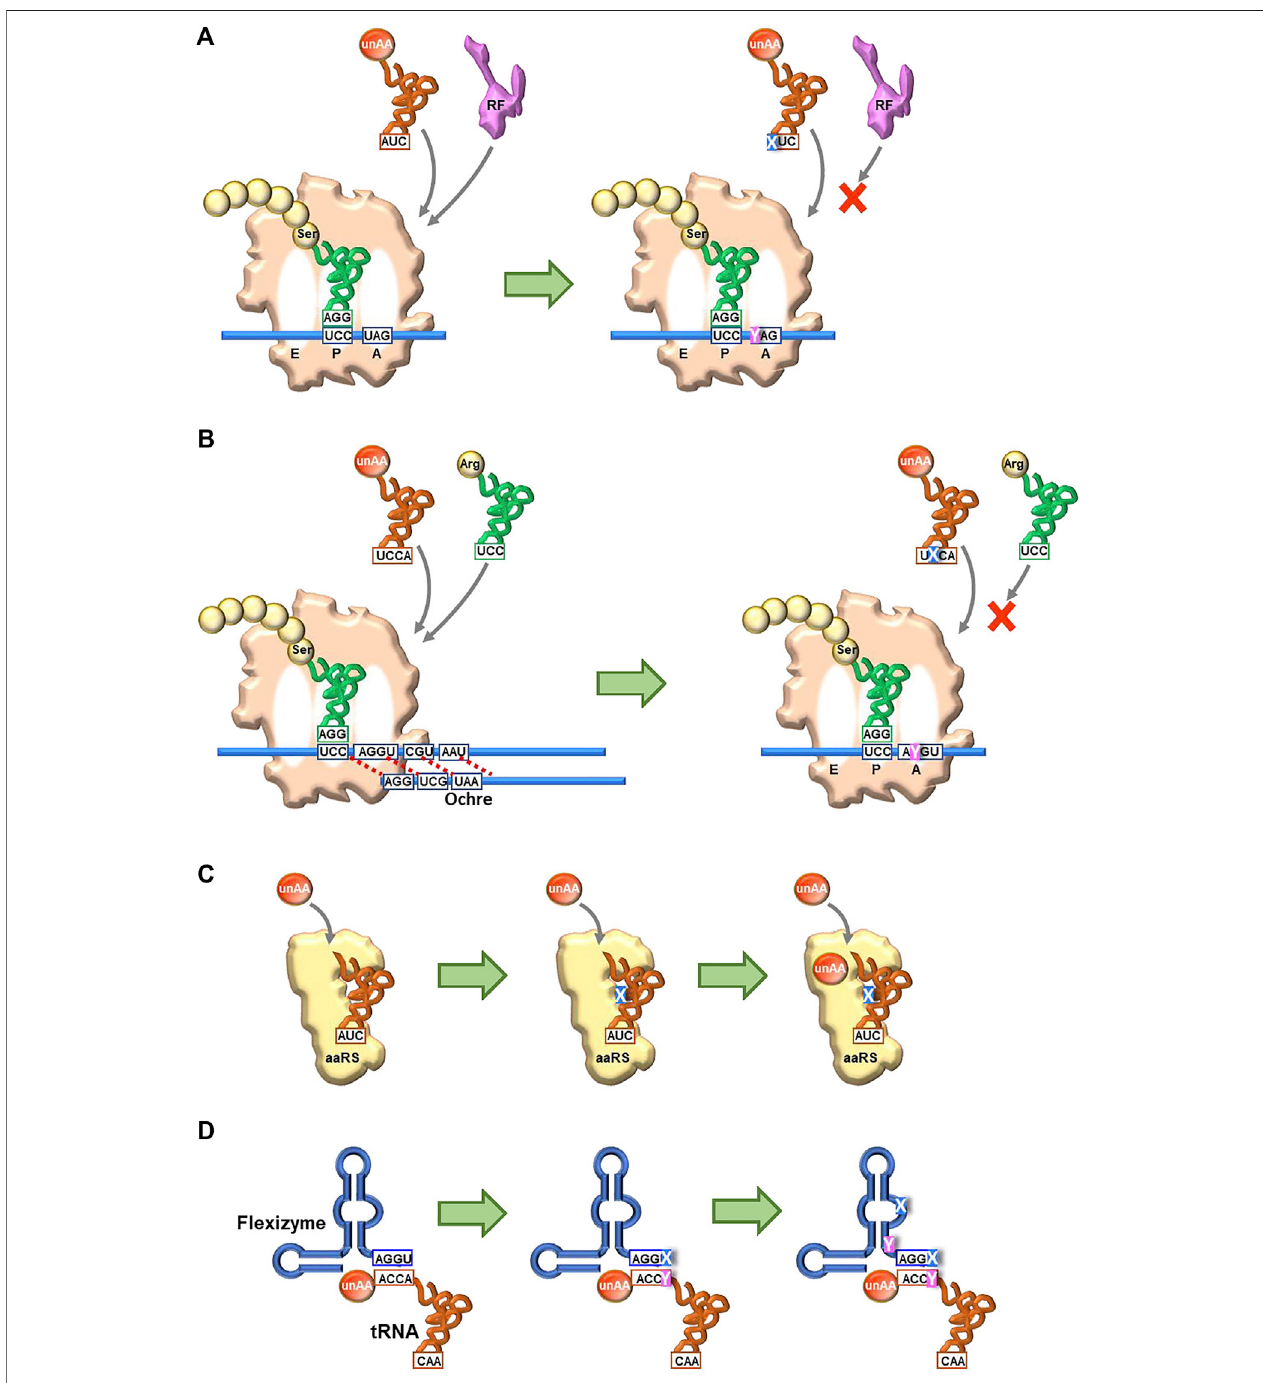
FIGURE 7 | Future perspectives to create new-anticodon interactions using UBP systems for unAA incorporation (A) Use of a stop codon (UAG) (B) Usage of a four-basecodon(quadrupletcodon) (C) CreationofneworthogonalengineeredtRNAandaaRSpairsforspeci fi cunAAaminoacylation,usingunnaturalnucleotidesand unAAs (D) Creation of new aminoacylation systems using engineered Flexizymes containing unnatural nucleotides.